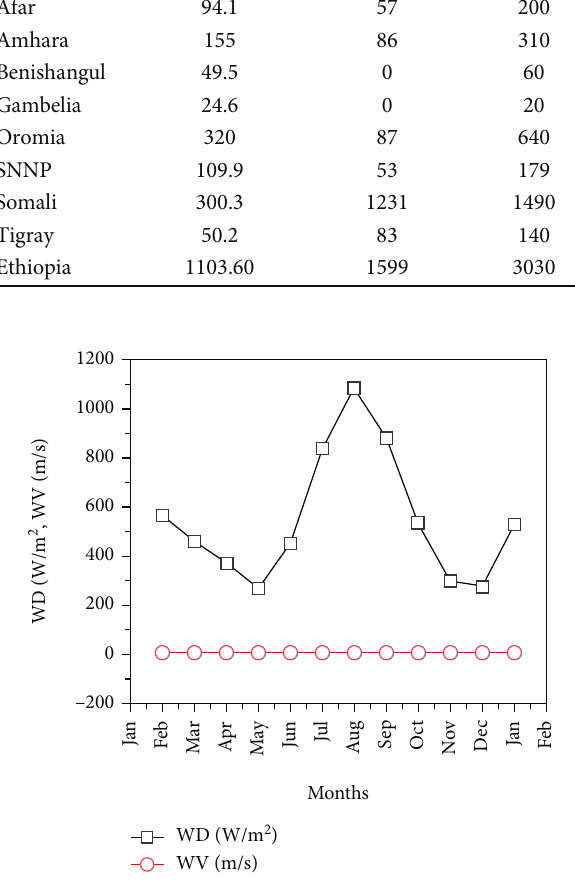
Figure 14: Monthly wind density and speed of the Afar